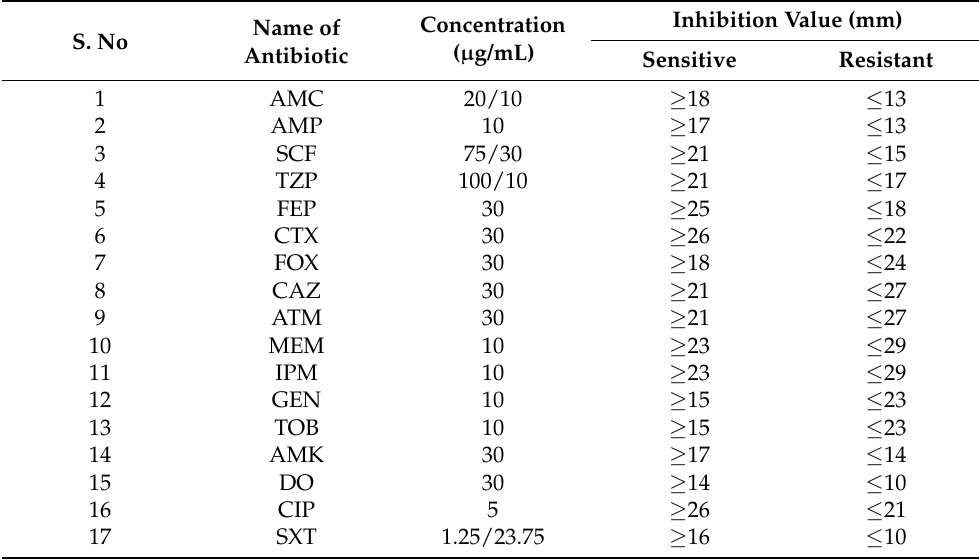
Table 10. Antibiotic disks along with the concentration used in the study.